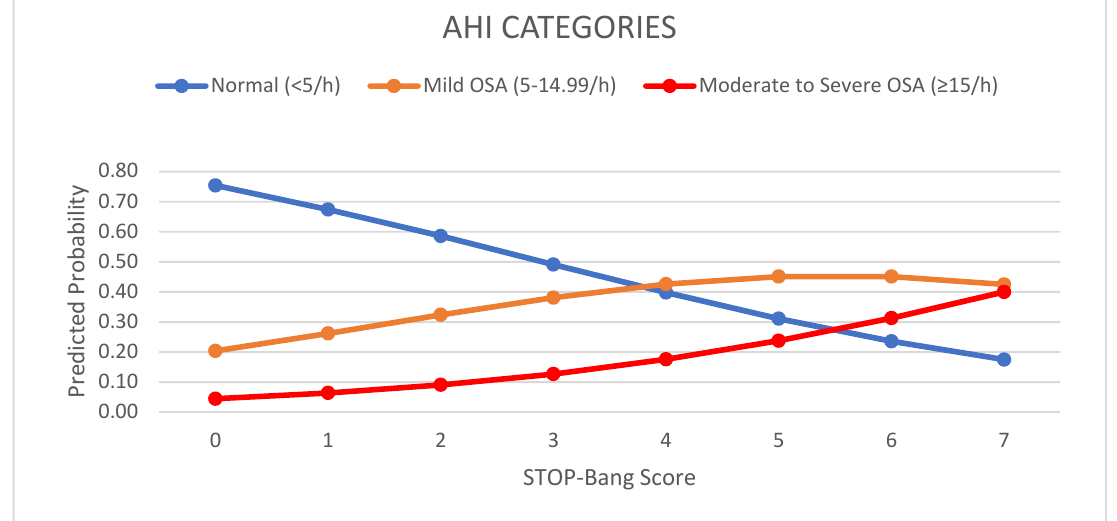
Figure 2. Predicted probability of sleep apnea severity based upon a linear model of the total population studied versus summary STOP-Bang scores (Numerical sum of the positive responses of the STOP-Bang model questionnaire).